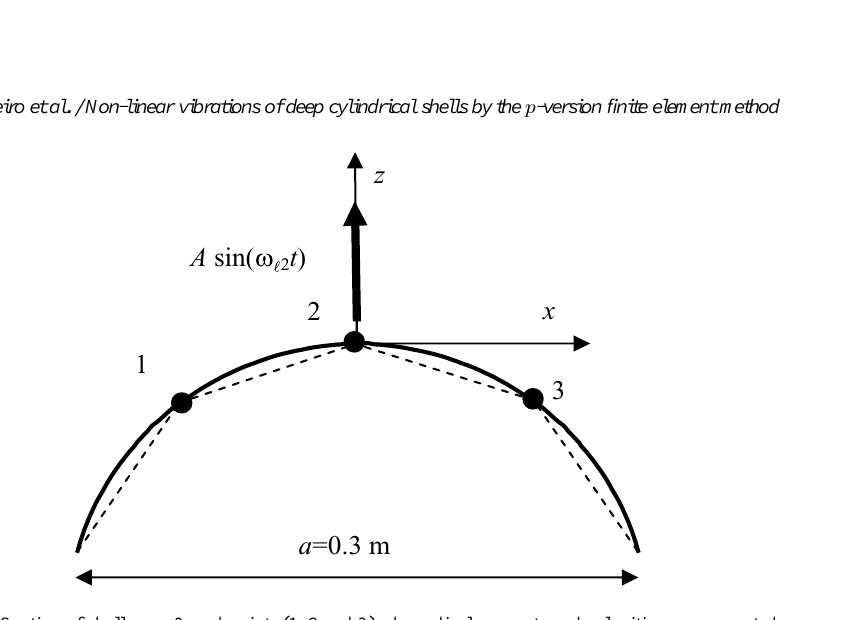
Fig. 4. Section of shell, y = 0, and points (1, 2 and 3) where displacements and velocities are computed.